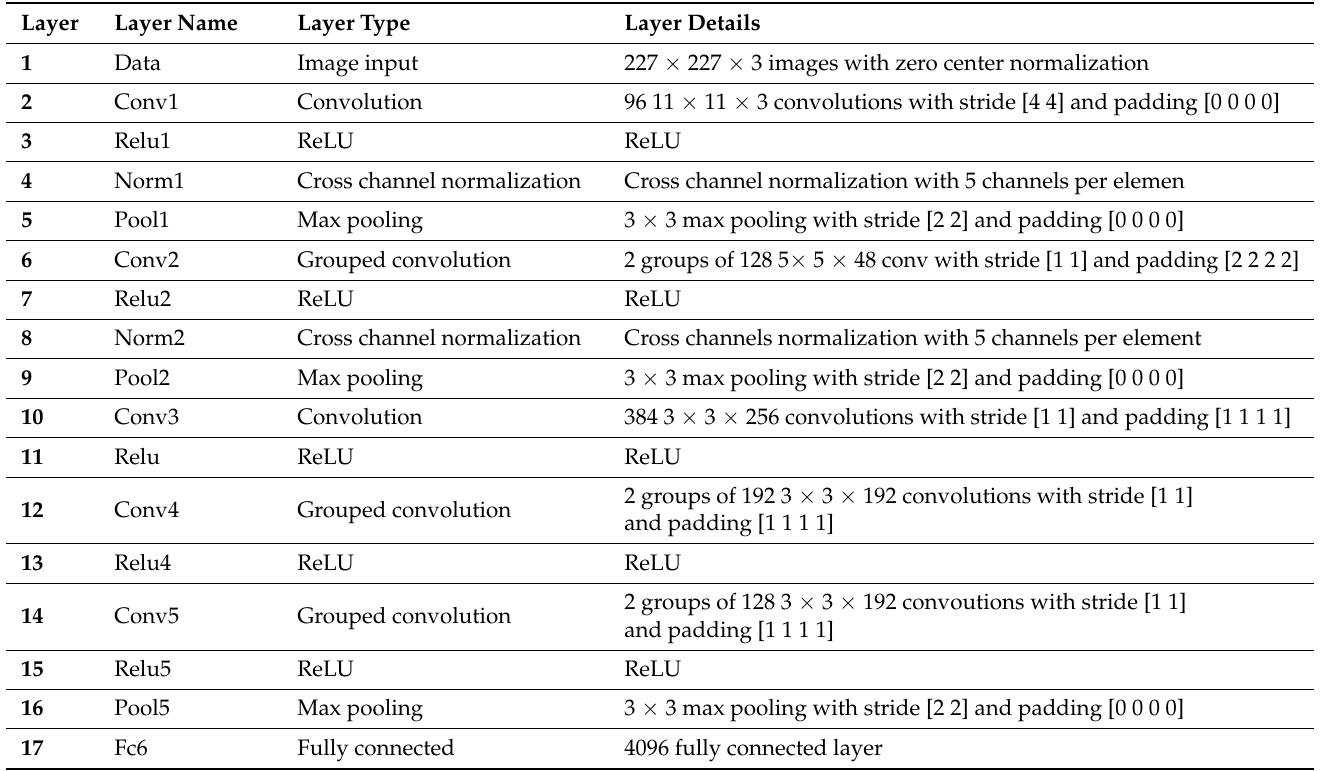
Table 1. AlexNet designed in this study.